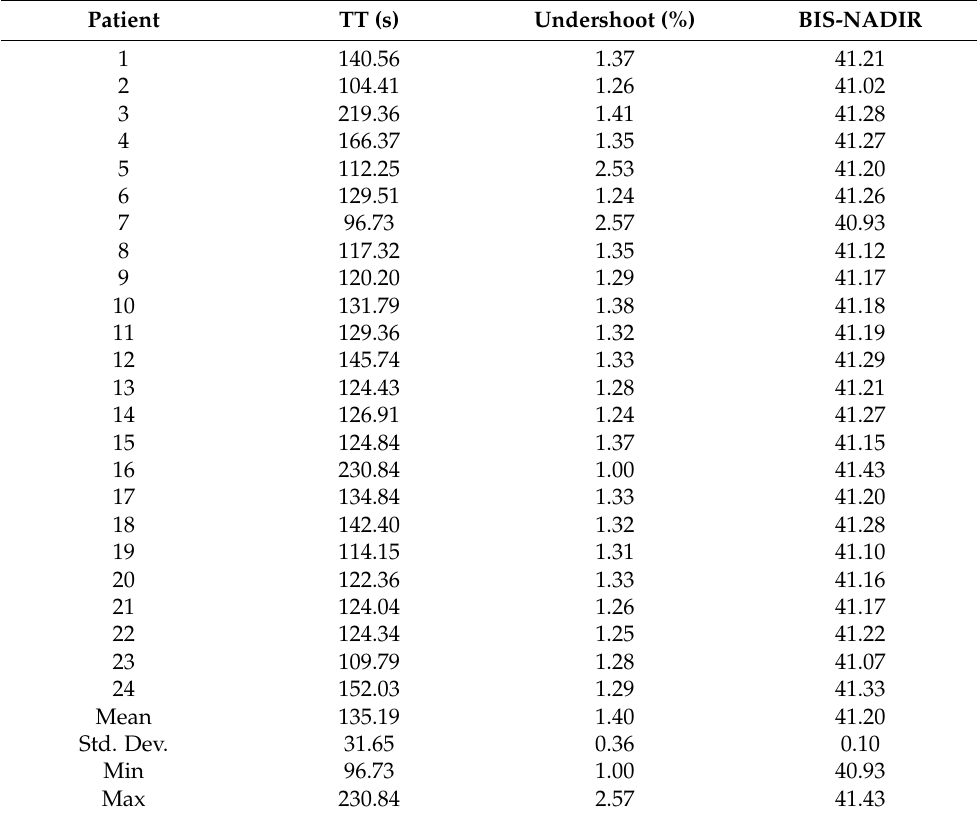
Figure 17. Dopamine and SNP control signals—simulation results with the proposed fractional-order switching function on all 24 patients. Table 5. Final induction-phase performances for each